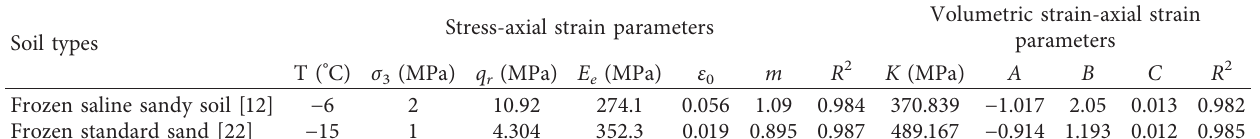
Table 4: Model parameters of frozen saline sandy soil and frozen standard sand.